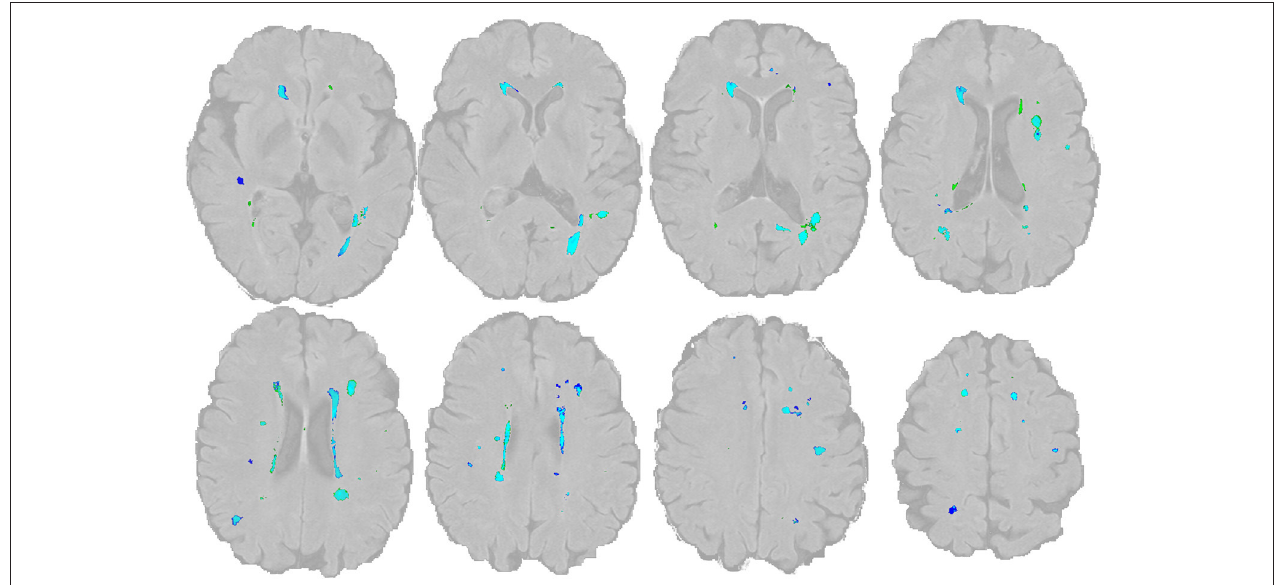
FIGURE 3 | Overlap of WMH lesion masks The manual lesion mask is shown in dark blue, the BIANCA lesion mask is in green (threshold: 0.8). The light blue color indicates the overlap of both. The image and mask are identical to Figure 1 .